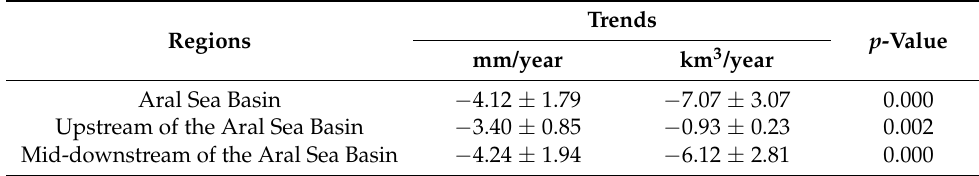
Table 3. Trends in TWSA of the Aral Sea Basin and the typical zones derived from GRACE.